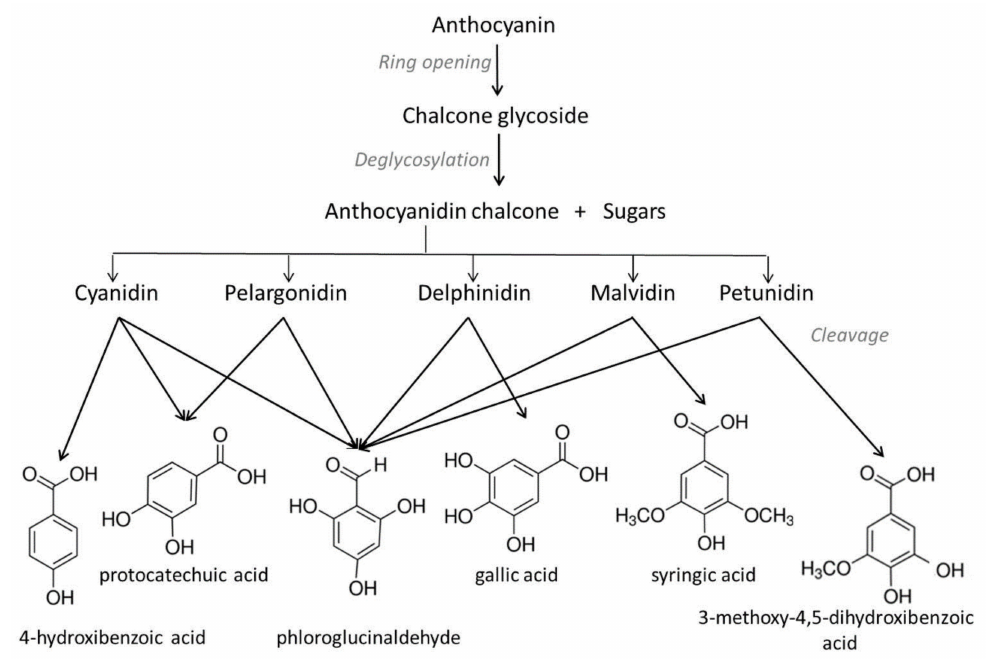
Figure 2. Possible mechanism of thermal degradation of the most common non-acylated